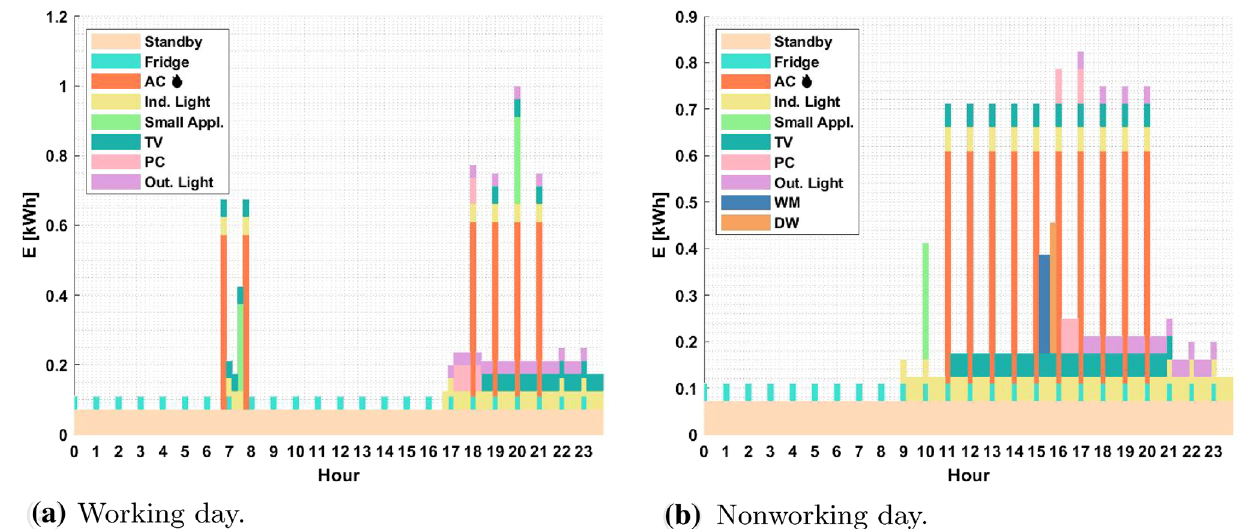
Fig. 5 Daily load profile, in each time interval, on the two significant days of